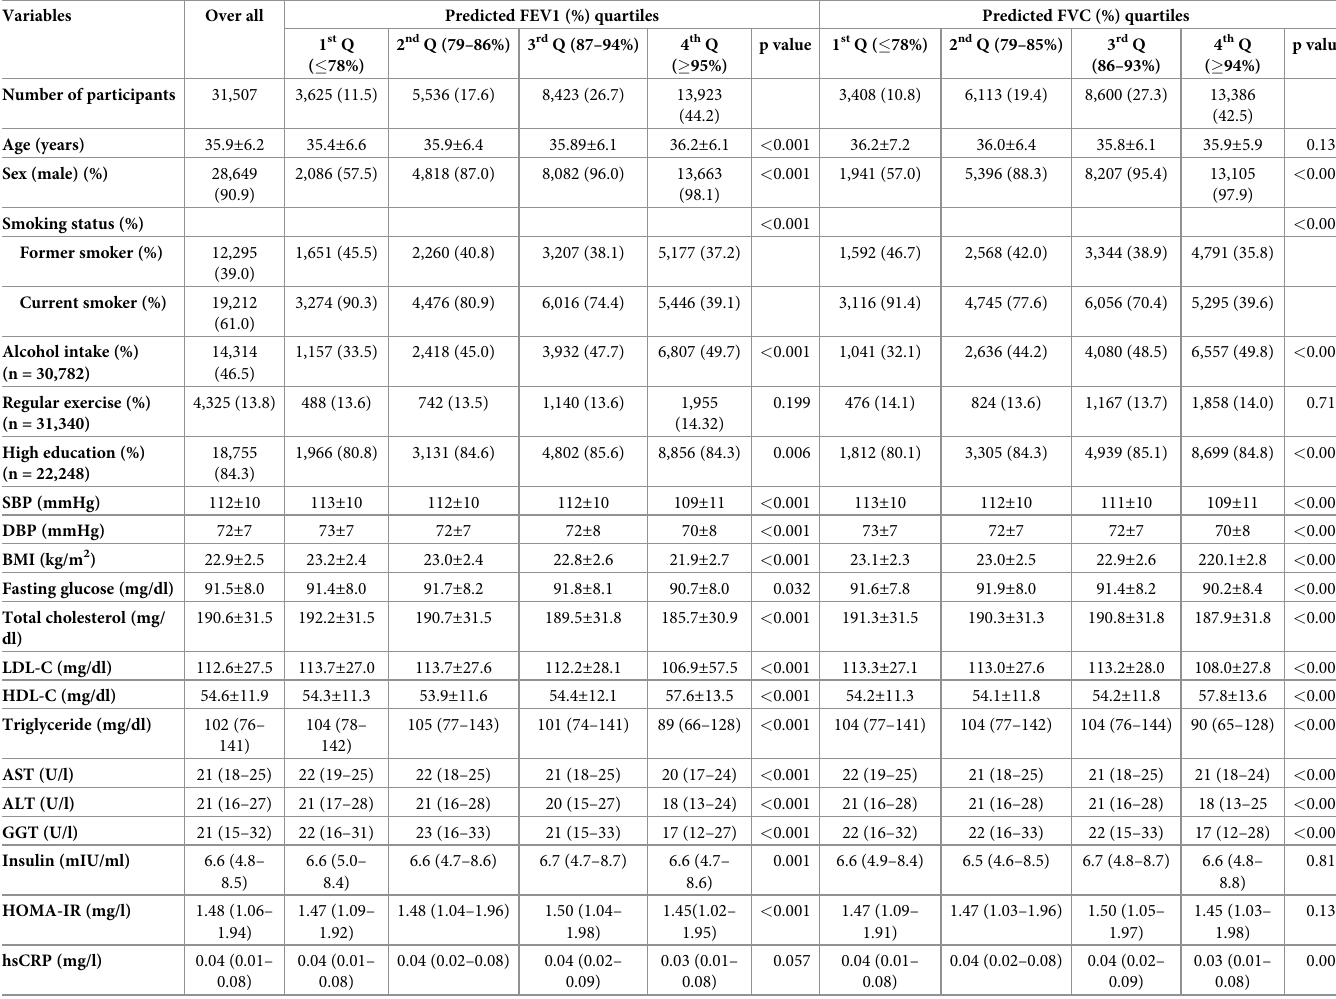
Table 2. Comparisons between Four Groups according to Initial Spirometric values in smoke-exposed subjects without NAFLD at baseline. Variables Over all Predicted FEV1 (%)